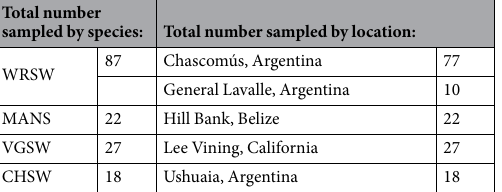
Table 3. Final sample sizes of nests/females used for the glm analysis with complete individual female information for the extra-pair paternity (EPP) model. Note that we did not use Tree swallows on this analysis, in spite of the fact that there are many papers on their genetic parentage, because we did not have access to individual female information from the papers used as reference. VGSW = Violet-green swallow, MANS = Mangrove swallow, WRSW = White-rumped swallow, CHSW = Chilean swallow.